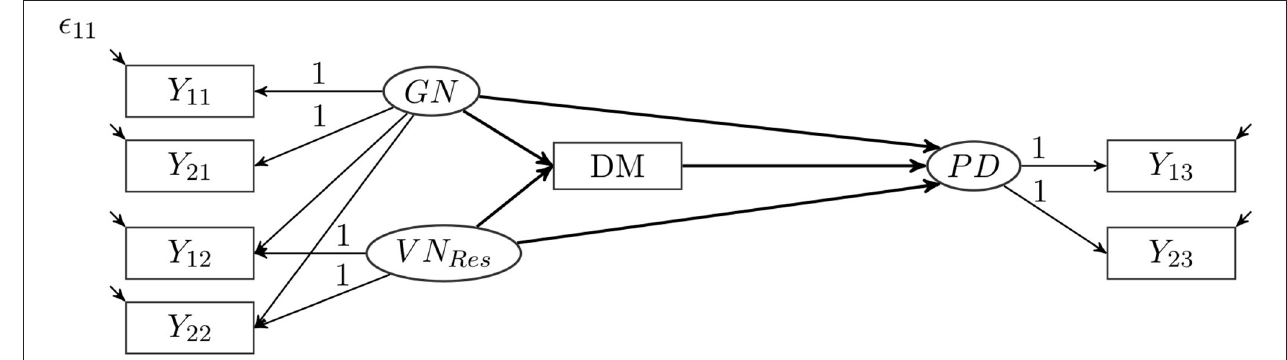
FIGURE 1 | Structural equation model of grandiose and vulnerable narcissism, defense mechanisms, and psychological distress.